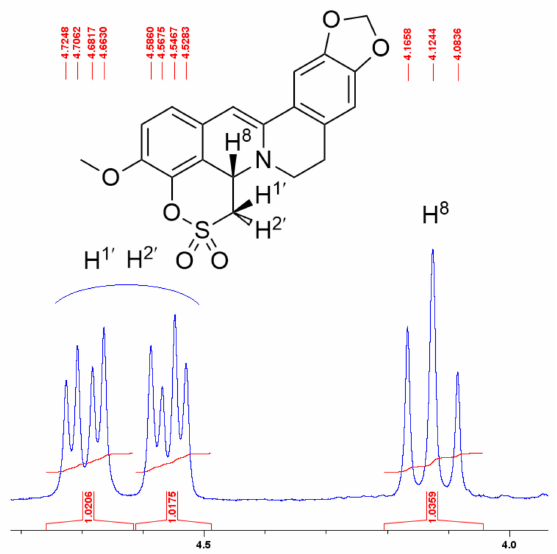
Figure 3. Fragment of 1 H NMR spectrum of compound 10a